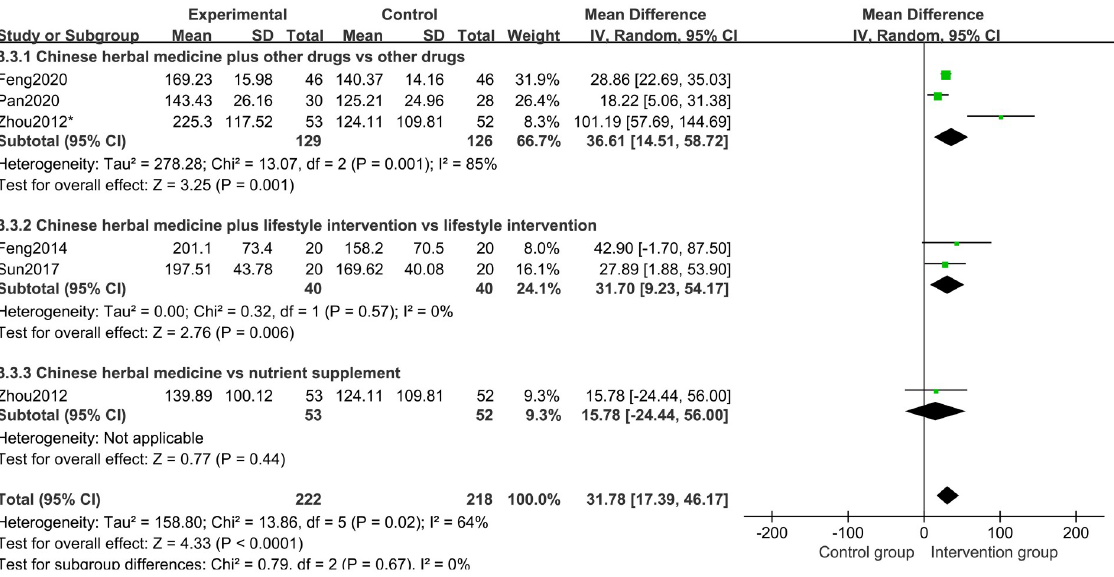
Fig 11. Subgroup analysis of IGF-1 level based on the